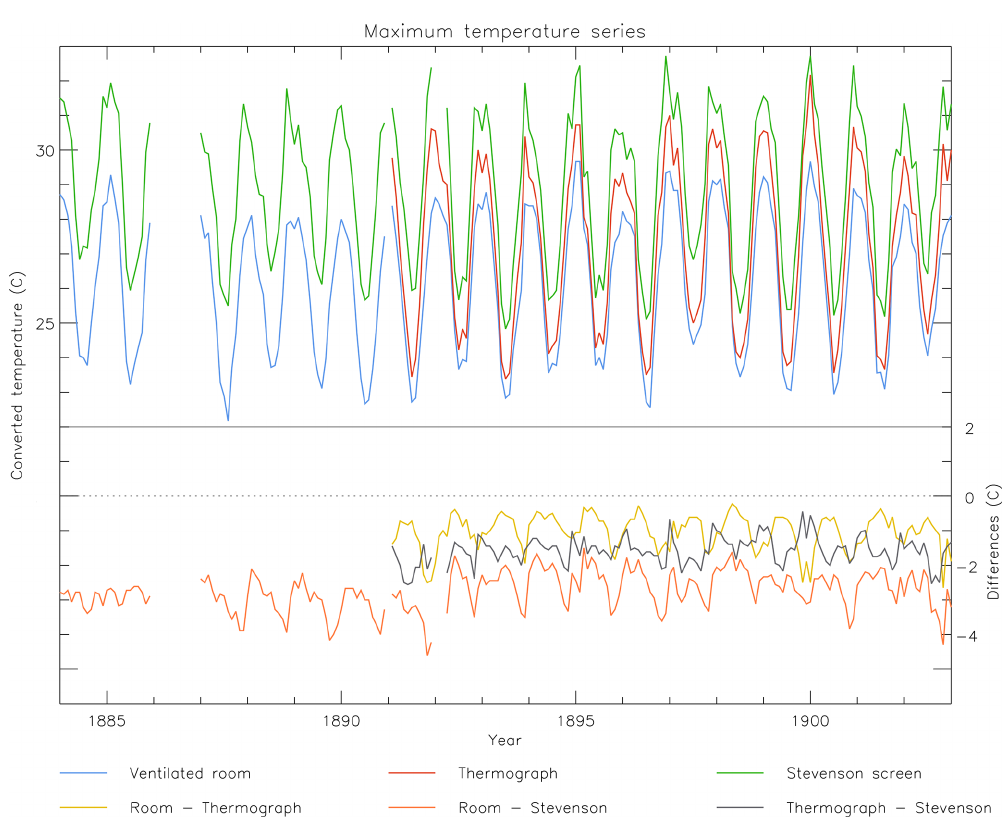
Figure 11. Monthly series for maximum temperatures as reported in the annual report series over the period of parallel measurements (1884–1903) from the three principal instrument series. The lower panel shows time series of the offsets between the measurements (in all cases first instrument minus the latter